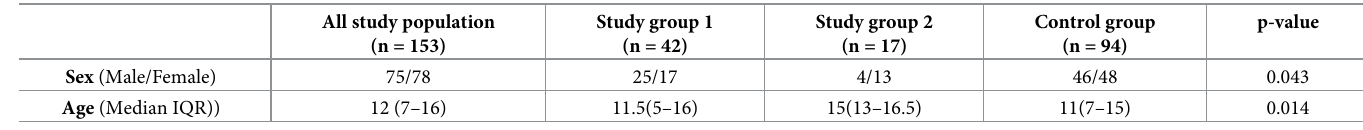
Table 1. Population demographic characteristics according to study groups.